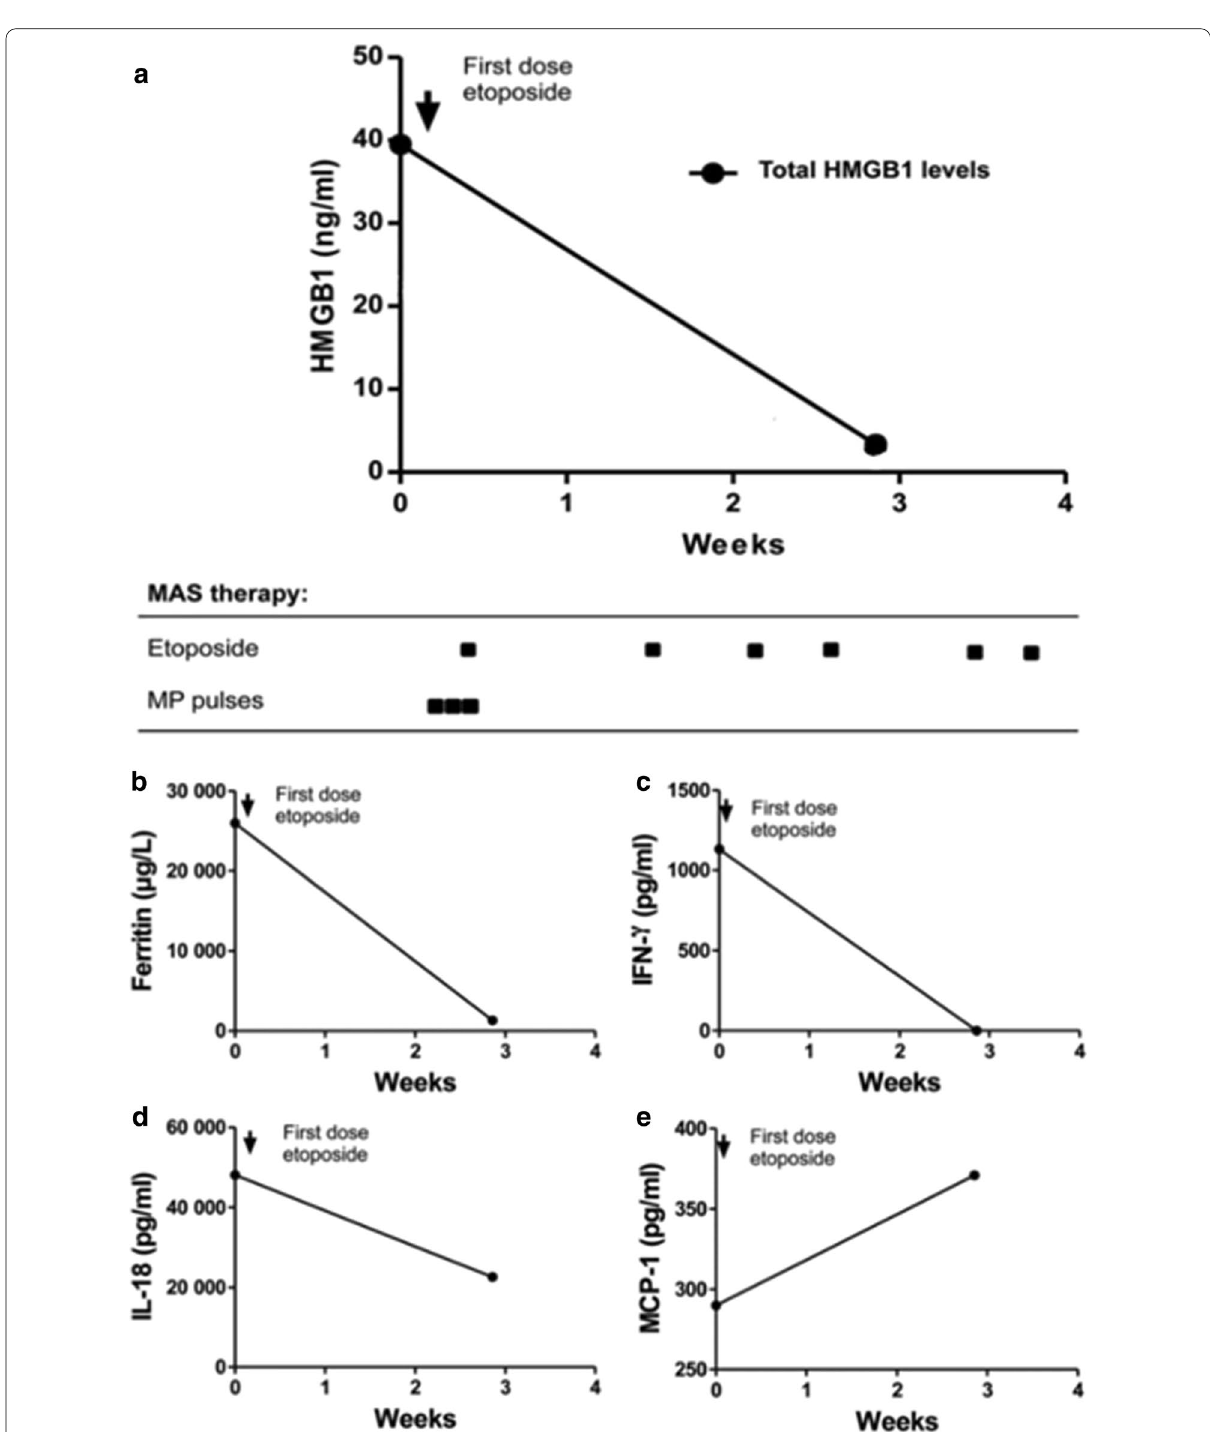
Fig. 2 Longitudinal serum analyses before and after etoposide treatment in patient #1. High plasma levels of HMGB1 were observed during severe disease ( a ), and rapidly declined after initiation of etoposide treatment concomitantly with serum concentrations of ferritin ( b ), IFN‑γ ( c ), and IL‑18 ( d ). MCP‑1 ( e ) levels peaked weeks later when the patient was recovering. CsA cyclosporine A; MP-pulses methylprednisolone